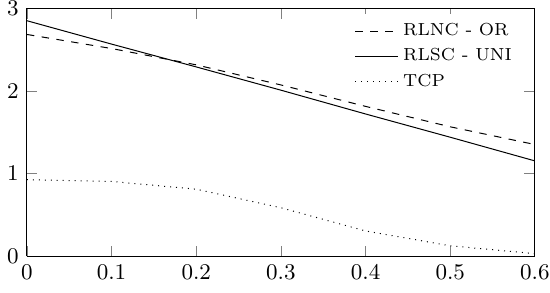
Figure 7: Performance comparison over a canonical scenario area of the nodes is modelled by a 20 meter disk radius, by correspondingly setting the MaxRange parameter of the RangePropagationLossModel .